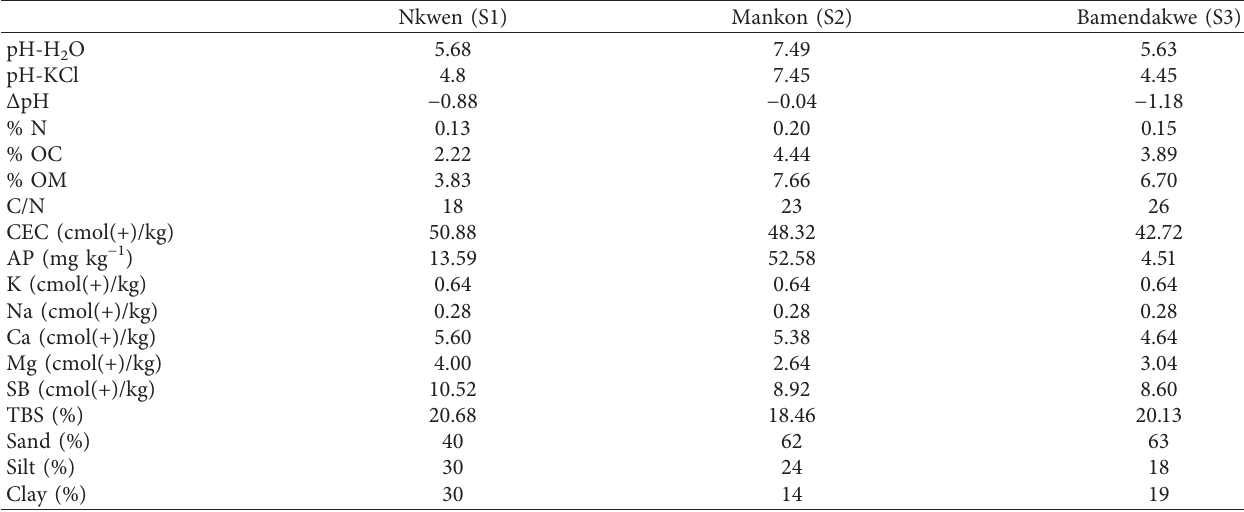
Table 1: Soil physicochemical